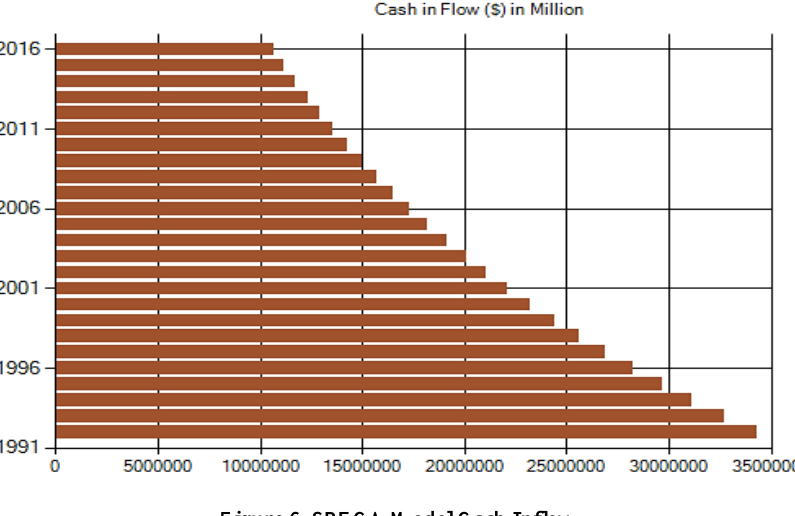
Figure 6. SPECA Model Cash Inflow